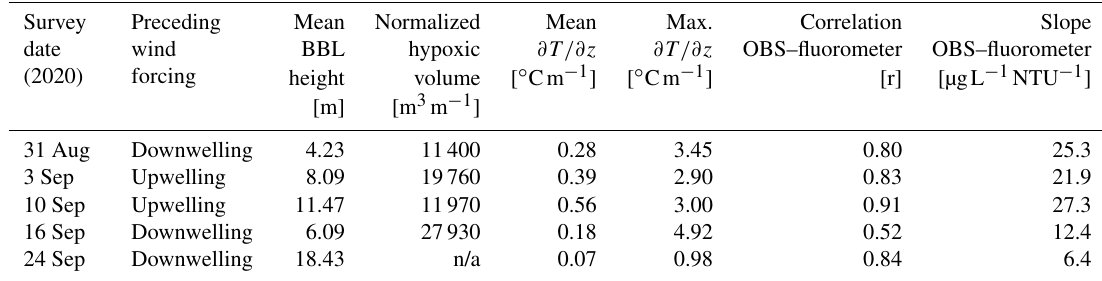
Table 1. Summary of conditions for 2020 cruises. Wind forcing is based on the mean north–south component of the wind over the preceding 1.5d ( ∼ inertial period) prior to the survey. Mean winds from the south are considered upwelling, and mean winds from the north are considered downwelling. Only data from the central transect shown in Fig. 1 are reported. Mean BBL height, mean ∂T/∂z , and max ∂T/∂z are the average values for all profiles collected on the transect ( n ∼ 11). BBL height is estimated from the vertical location where the maximum value of ∂T/∂z is observed. The normalized hypoxic volume is calculated as the vertical and across-shelf extent of water with DO concentration < 3mgL − 1 and is normalized by distance in the along-isobath direction (e.g., units of area).